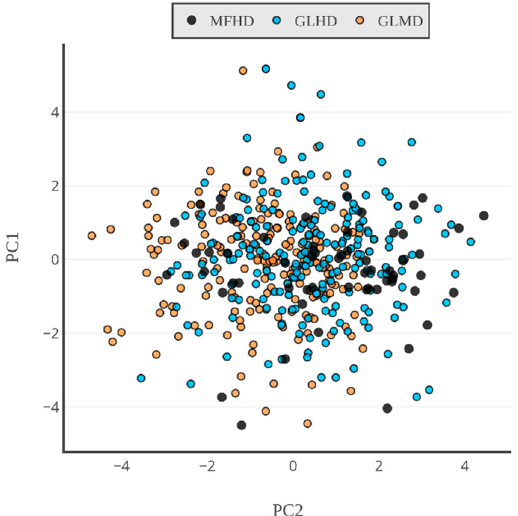
Figure 4. PCA ordination of the proteins from MFHD, GLHD, and GLMD based on their amino acid compositions (for values, see Table S3).